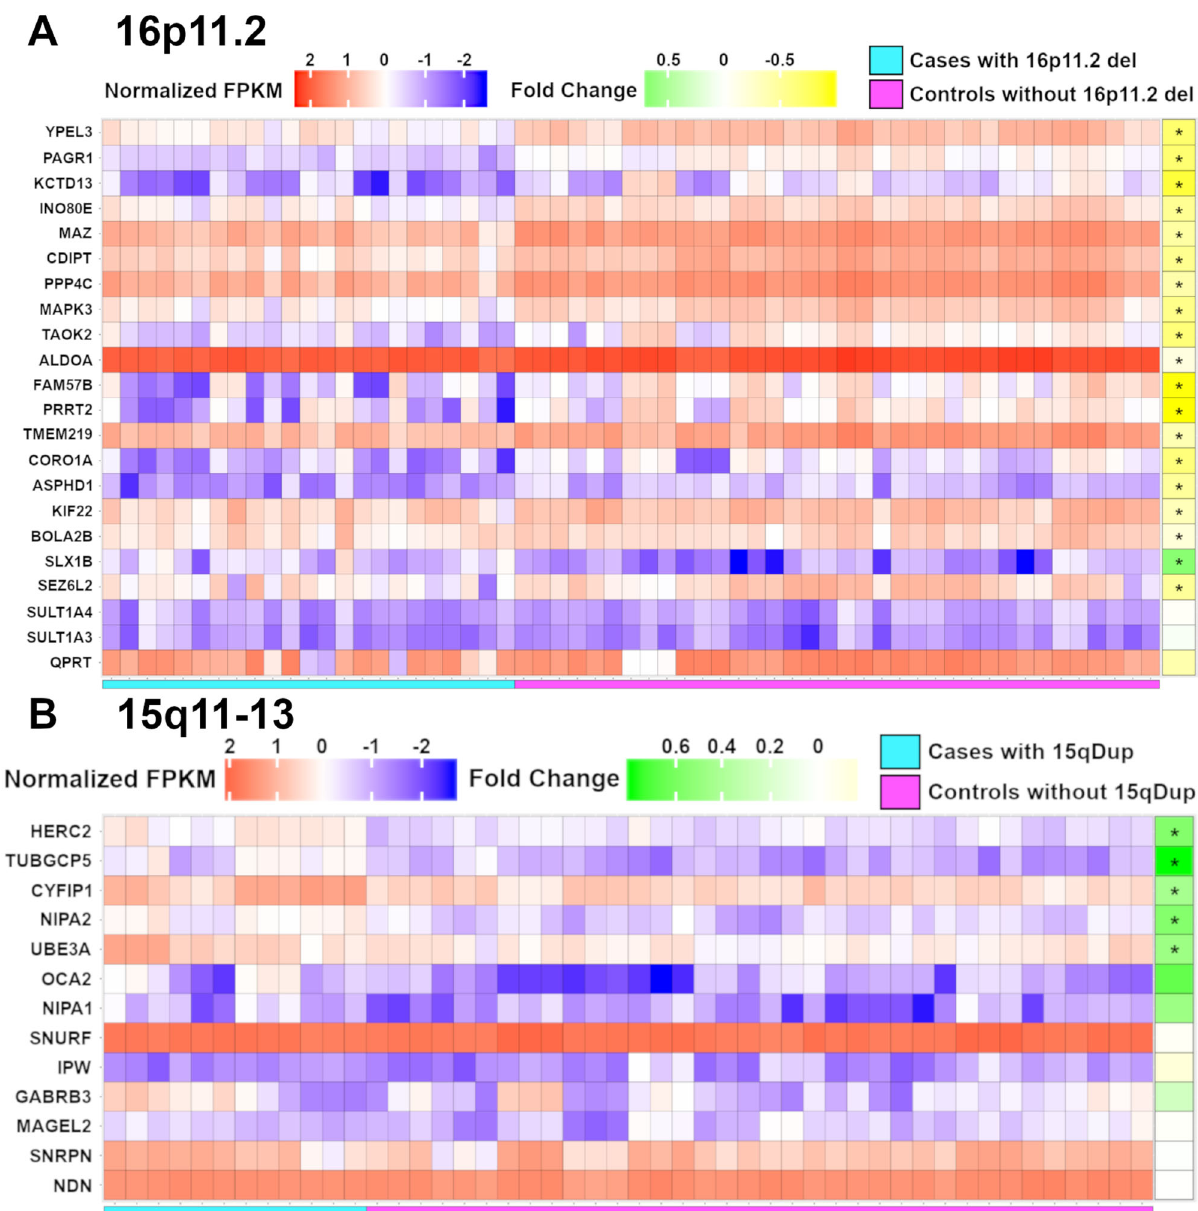
Fig. 2 Expression of the gene products in the 16p11.2 and 15q11-13 loci. All data were analyzed from 71 bRNA-seq samples over 25 donors. A Heatmap representation of the normalized expression (FPKM) for all samples across the 22 genes in the 16p11.2 locus. The fold change is represented as a green- yellow heatmap. An asterisk on the “ Fold Change ” heatmap indicates signi fi cant differential expression of the gene with FDR ≤ 0.05. B Heatmap representation of the normalized expression (FPKM) for all samples across the 13 genes in the 15q11 – 13 locus. The fold change is represented as a green- yellow heatmap. An asterisk on the “ Fold Change ” heatmap indicates signi fi cant differential expression of the gene with FDR ≤